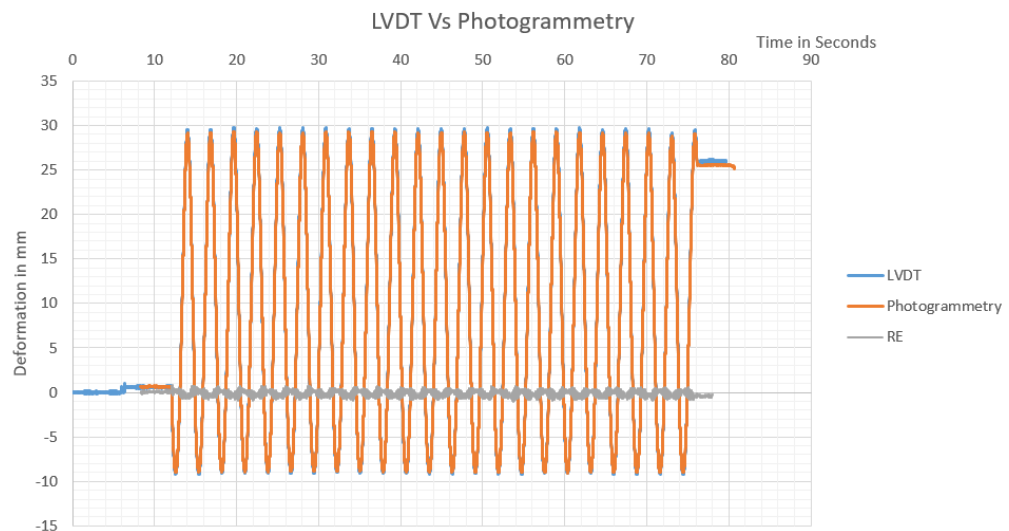
Figure 12. Shaking table monitored oscillations using LVDTs vs. photogrammetry from the first monitoring station.